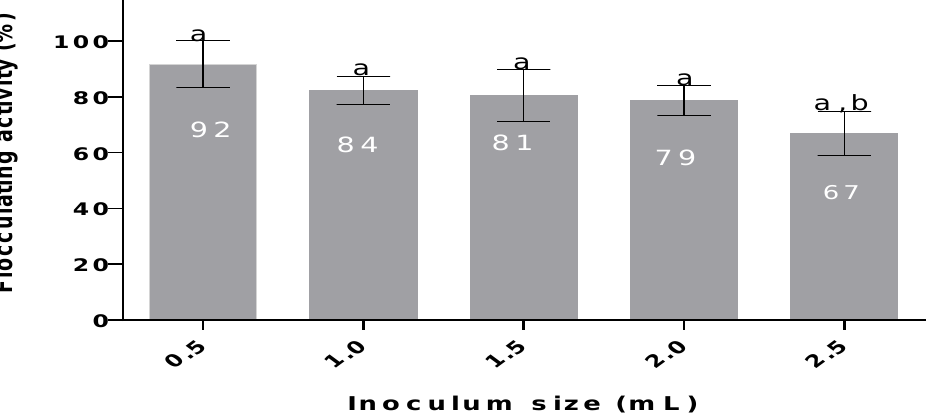
Figure 1. The effect of inoculum size on bioflocculant production. Different letters (a,b) signify statistical significance at ( p < 0.05). Table 1. Effect carbon and nitrogen sources, speed, temperature, cation, and pH on